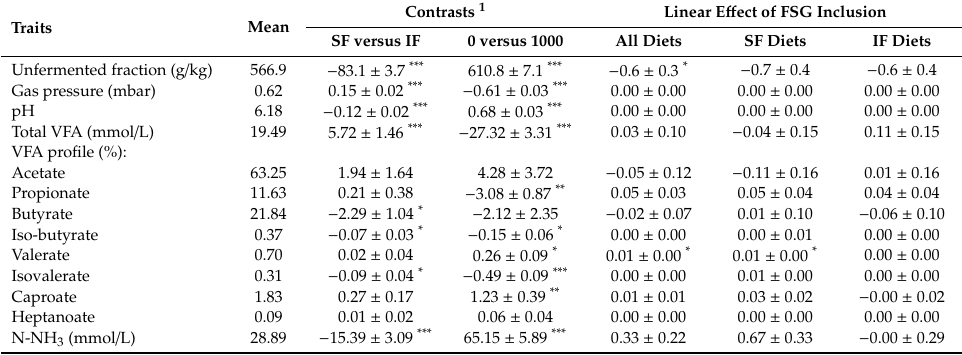
Table 5. E ff ect of fenugreek seed gum (FSG) inclusion in the experimental diets (SF and FI) on some fermentation traits after an in vitro fermentation with caecal inoculum of the indigestible fraction obtained from the in vitro enzymatic digestion with pepsin and pancreatin (least square means ± standard